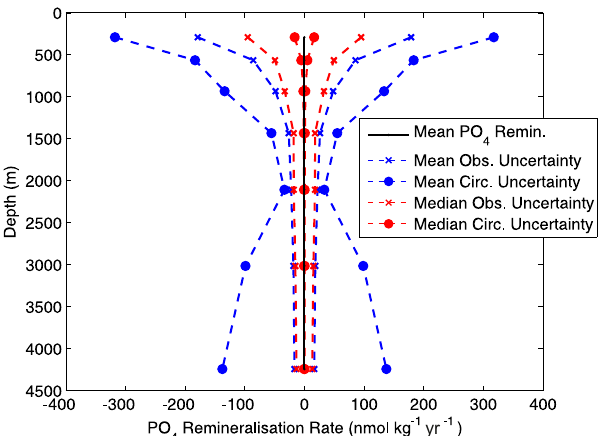
Figure 8. Comparison of error magnitudes when estimating rem- ineralisation rates. The global mean PO 4 remineralisation profile from the synthetic data set is shown with the plus and minus the mean and median SDs from the ERR-OBS and ERR-CIRC experi-